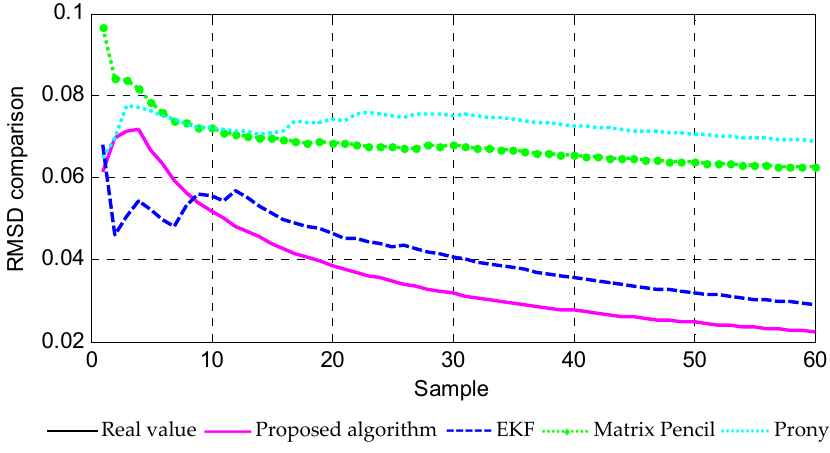
Figure 6. Estimation of ω 3 , δ 3 by using different methods.